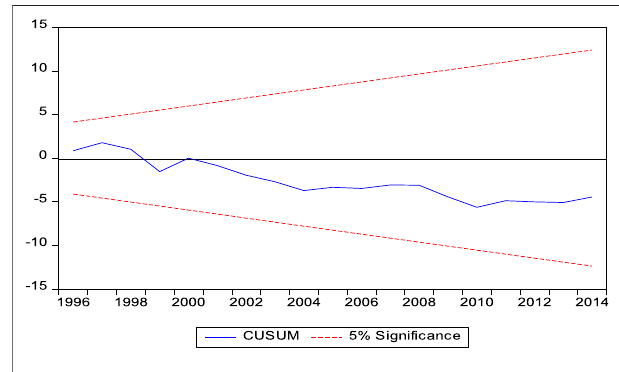
FIGURE 7 | CUSUM energy consumption.